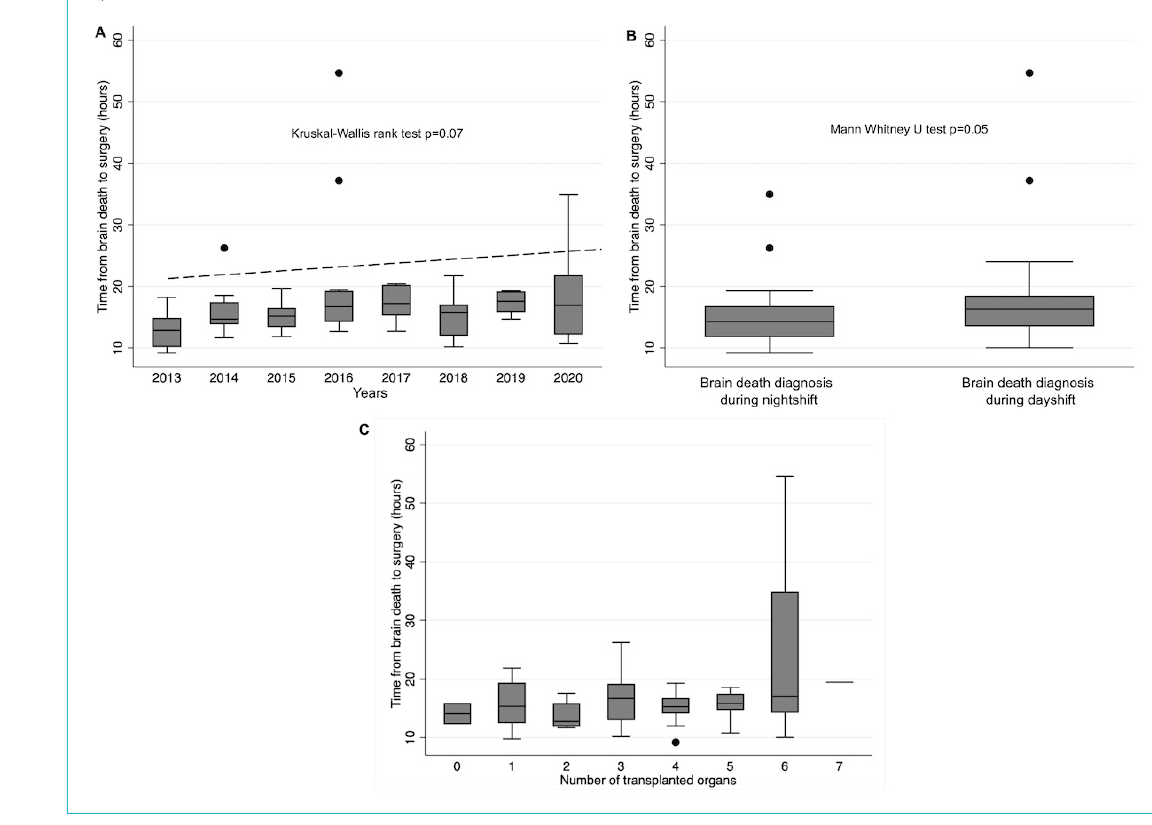
Figure 1: (a) Median time from diagnosis of brain death to start of surgery over time (n = 76); (b) median time from diagnosis of brain death to start of surgery during day shifts versus night shifts (n = 76); (c) time from death to surgery in relation to the number of organs explanted (n =